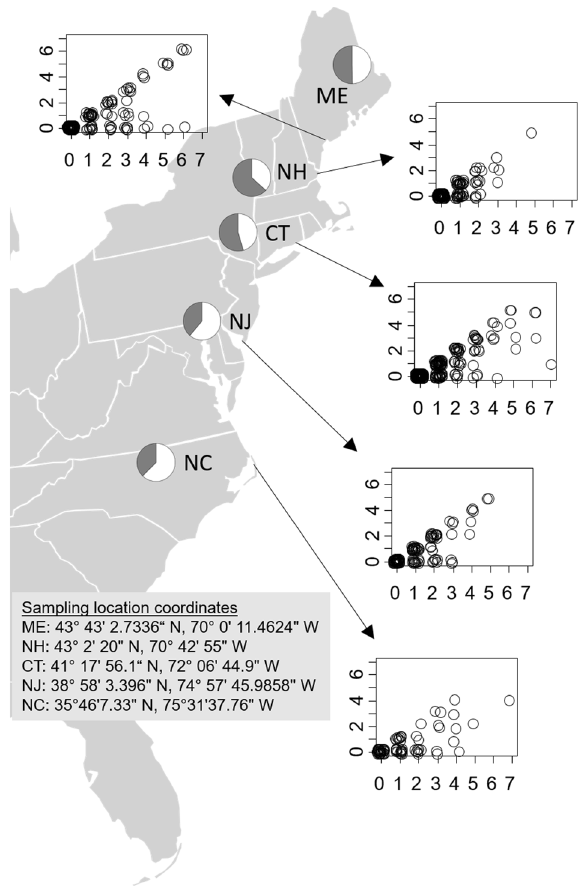
Figure 1. Map of the US east coast showing the five sampling sites used in 2020 along with the GPS coordinates for each sampling site. Letters on map are state abbreviations. Pie charts next to letters for each state show an increasing proportion of Hemigrapsus sanguineus that are injured at sites towards the southern end of the range (white = injured; gray = uninjured). The origins of the arrows pointing to each graph show the approximate locations of sampling sites. The x-axis on each inset graph is the number of missing limbs, and the y-axis on each inset graph is the number of limbs that were regenerating per crab. The data are jittered along the x-axis for clarity of presentation. Crabs missing no limbs are included in figures for completeness but were not included in statistical analyses to avoid